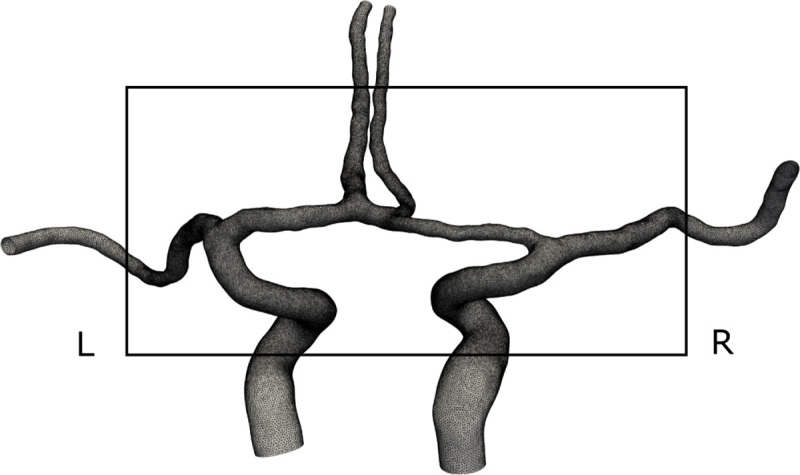
A computational geometry and mesh from a representative patient.From the posterior view, with left and right denoted in the figure. Note how only the anterior part of the CW was included in the model, according to our model assumption. The black square shows the mesh refinement region of our simulations. Longer segments of the arteries were included as flow extensions.